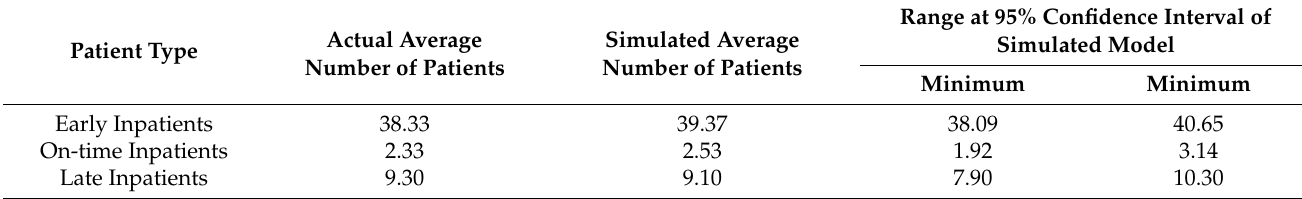
Table 7. Inpatient actual average number of arrivals and simulated average number of arrivals in 5